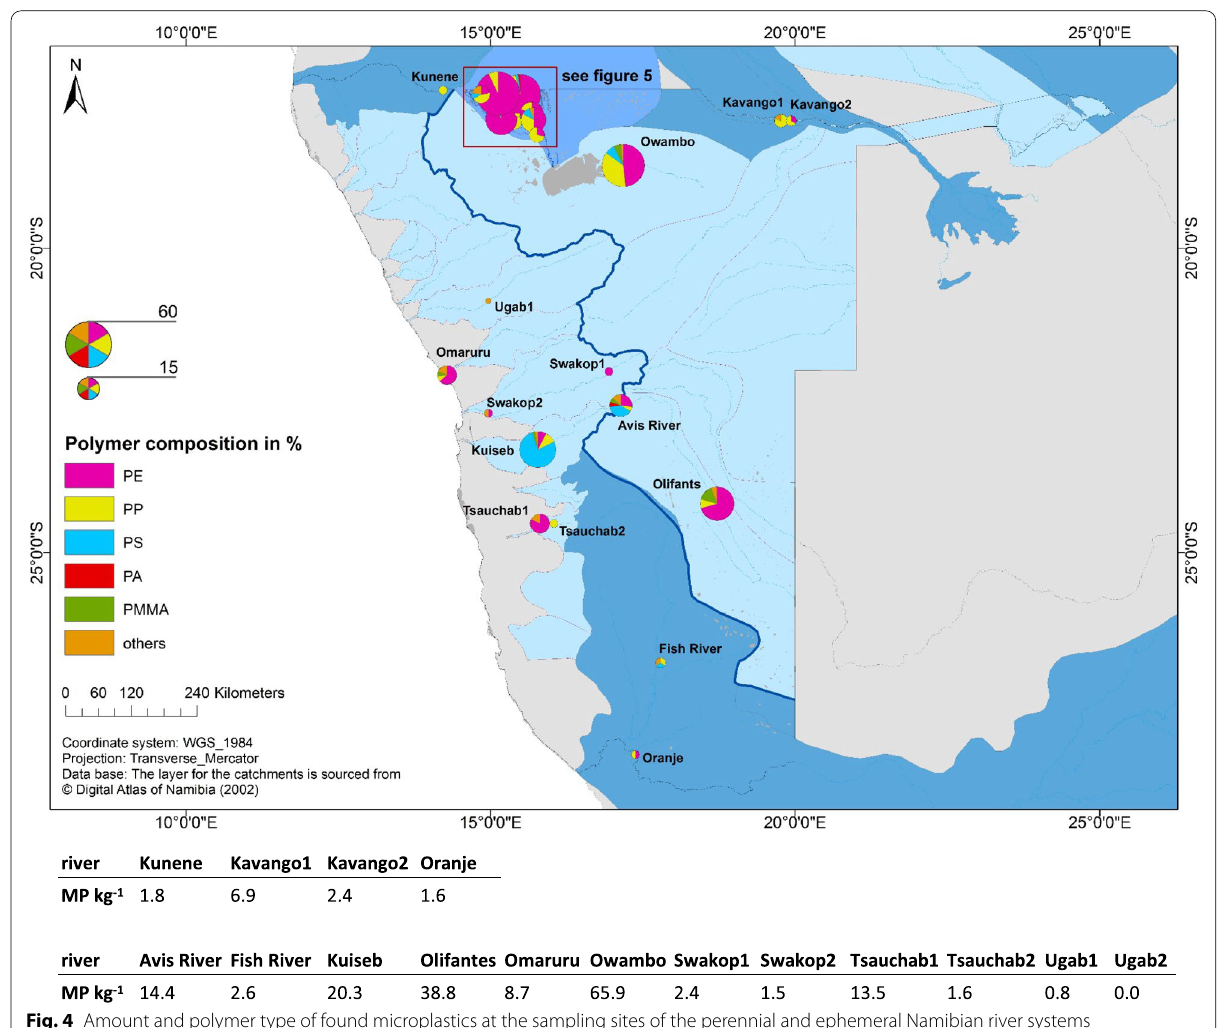
Fig. 4 Amount and polymer type of found microplastics at the sampling sites of the perennial and ephemeral Namibian river